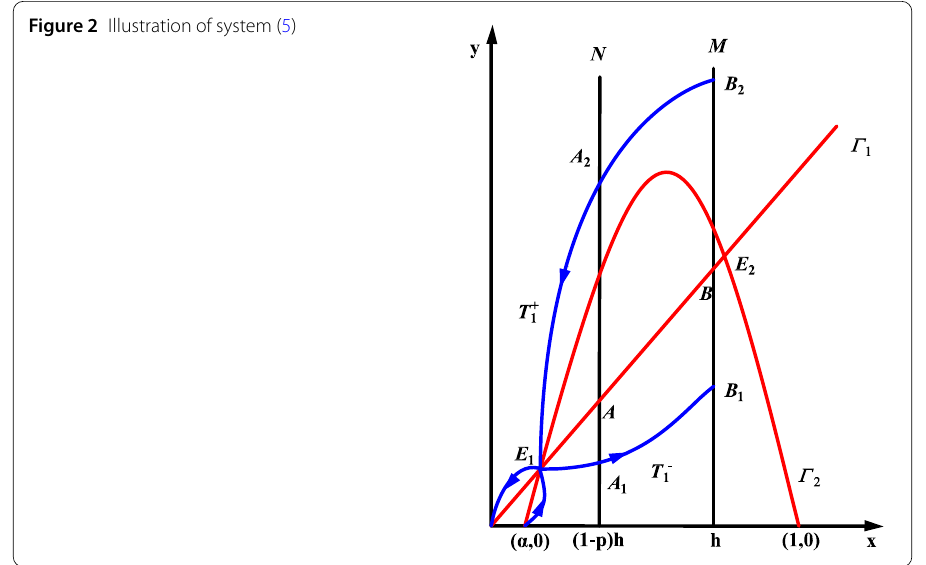
Figure 2 Illustration of system